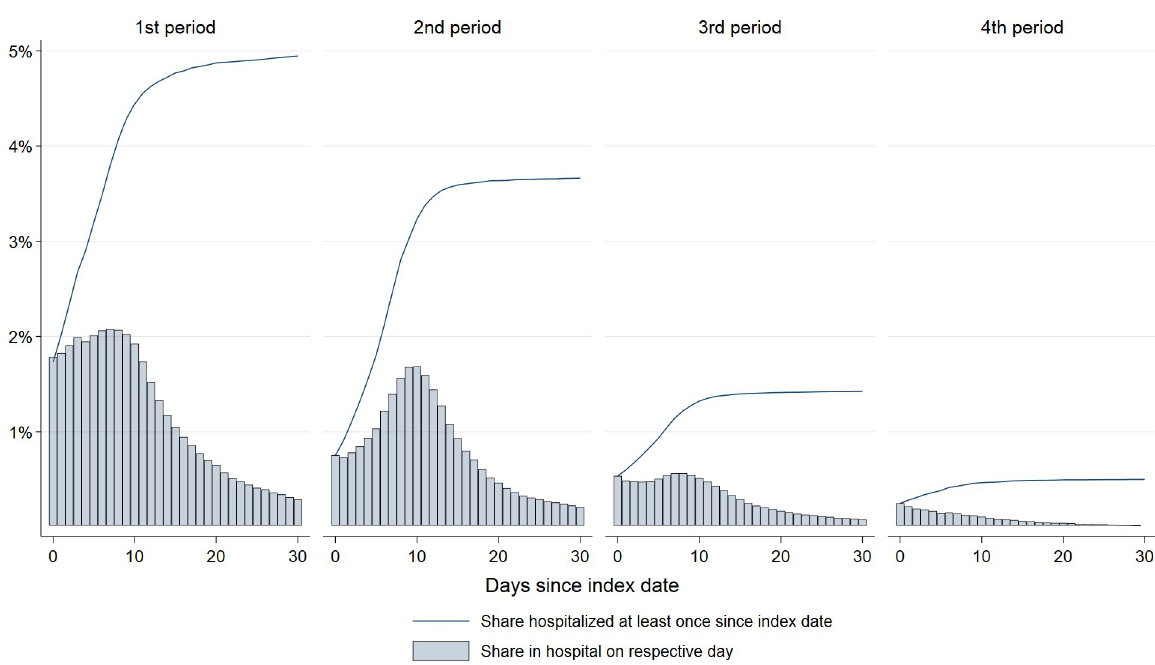
Fig 4. Shares seeking inpatient care. Day by day and cumulative shares seeking inpatient care from the day of testing positive (day 0) to the 30 th day after positive test, during four waves/periods of the pandemic: February 26 th , 2020 –February 16 th , 2021 (1 st period), February 17 th , 2021 – July 10 th , 2021 (2 nd period), July 11 th , 2021 –December 27 th , 2021 (3 rd period), and December 28 th , 2021 –January 14 th , 2022 (4 th period).